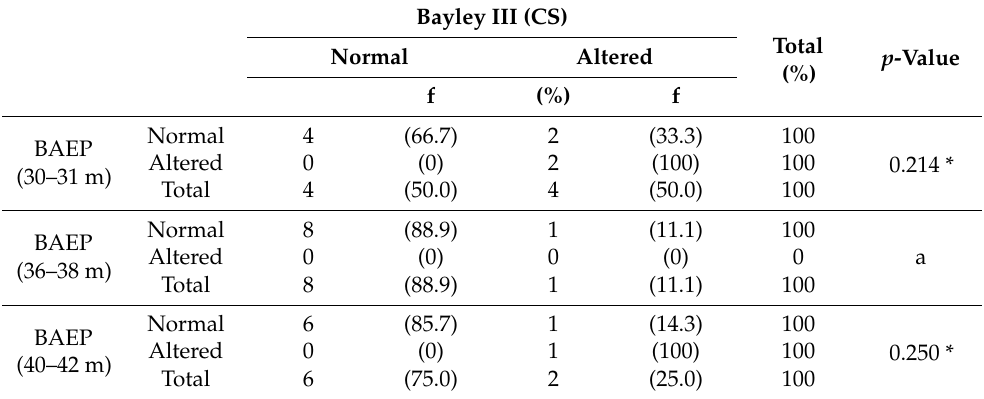
Table 3. Association between the BAEP variable (considering two sides) and Bayley III (composite score—CS).